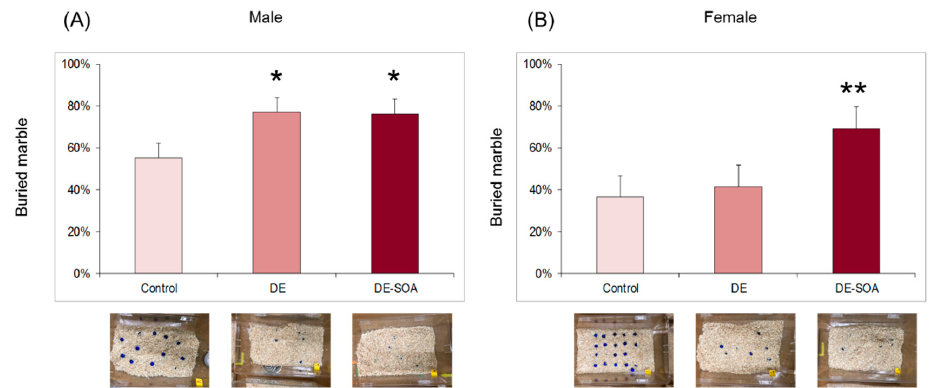
Figure 3. Assessment of repetitive behavior using marble burying test. Repetitive behavior in ( A ) male and ( B ) female rats of the control and the DE ‐ and DE ‐ SOA ‐ exposed rats ( n = 16, ** p < 0.01, * p < 0.05 vs. corresponding control).